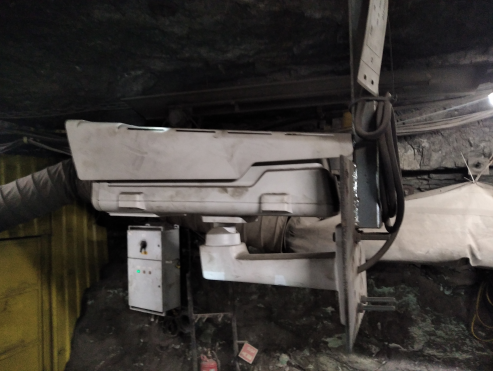
Figure 2. Measuring equipment—RGB camera to monitor the working conditions of the transfer